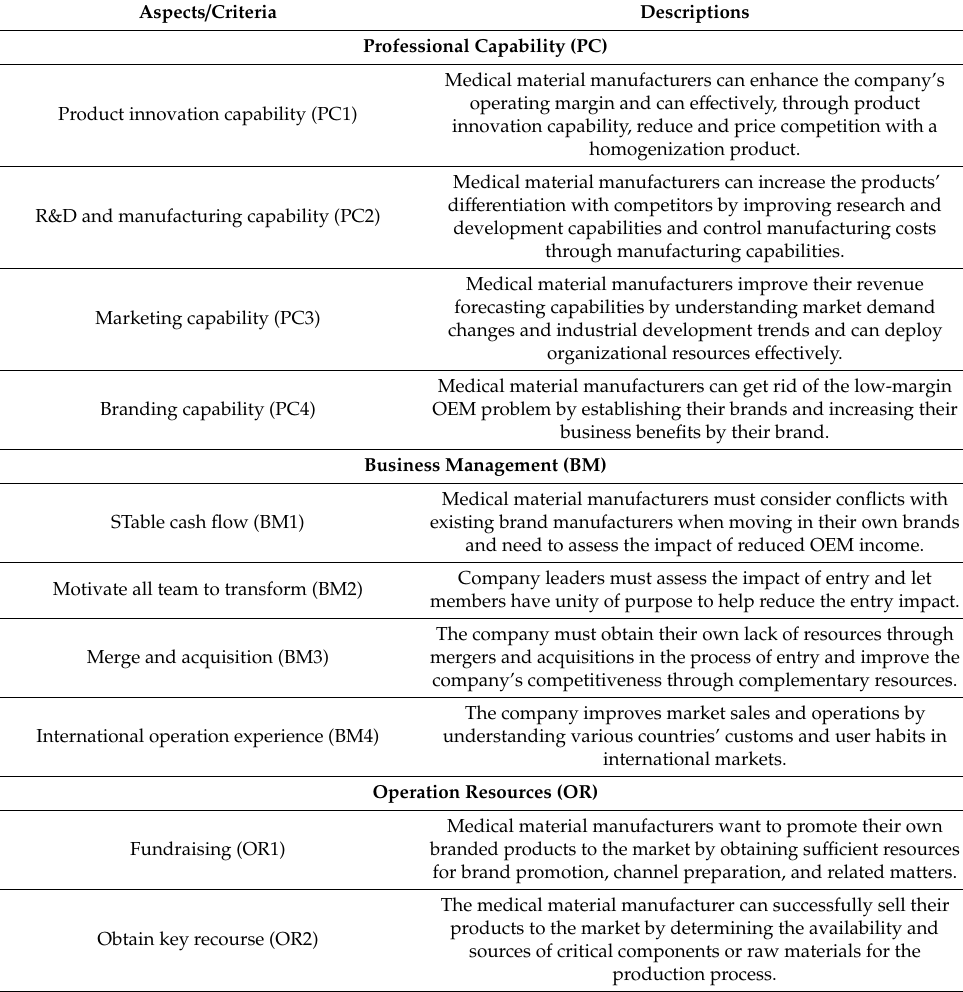
Table 1. The descriptions of aspects / criteria for industrial entry consideration of the Med-Tech